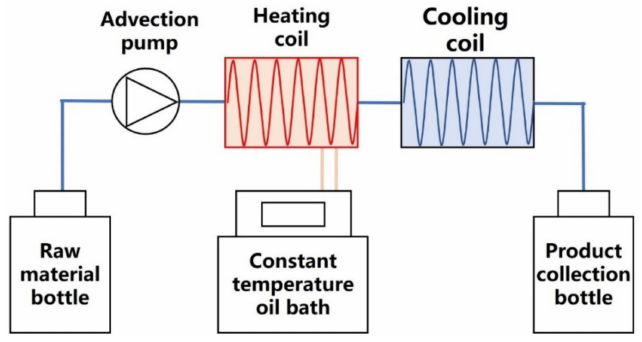
Figure 1. Schematic diagram of continuous flow